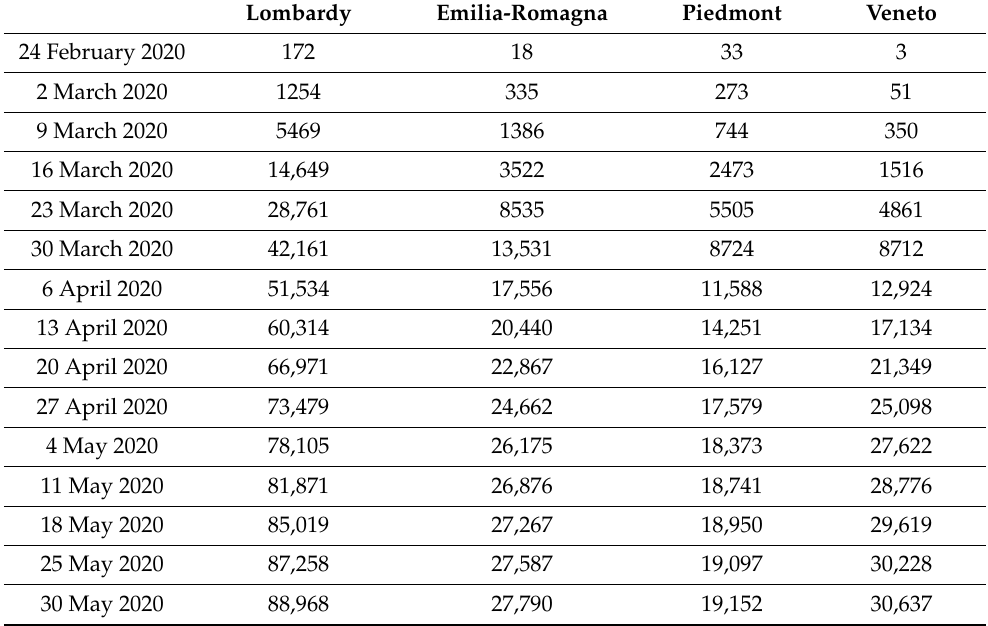
Table 1. Total COVID-19-positive cases on 31 May 2020 for the four regions most affected in terms of deaths and for which it was possible to derive all of the data in relation to the first wave of COVID-19.